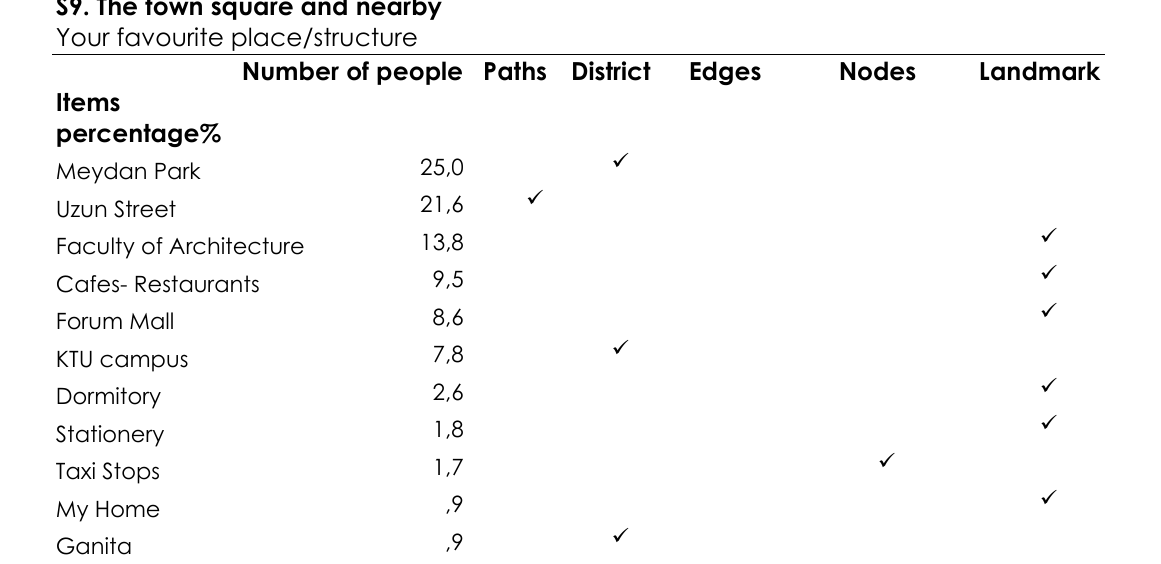
Table 6. Percentage (%) distribution of the most used place/structure preference of the participants in the city square and its immediate